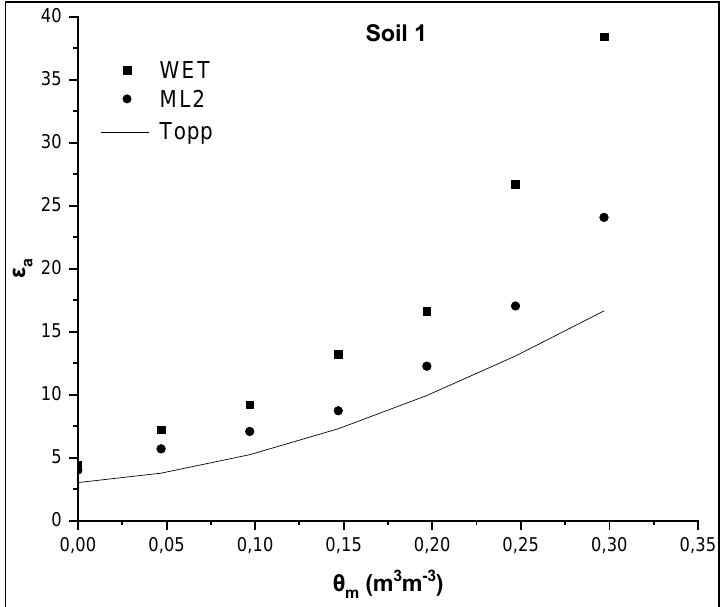
Figure 2. Comparative presentation of relationships θ m ‐ε a obtained by the WET sensor, the ML2 sensor and the TOPP equation for soil 1. Water 2019 , 11 , x FOR PEER REVIEW